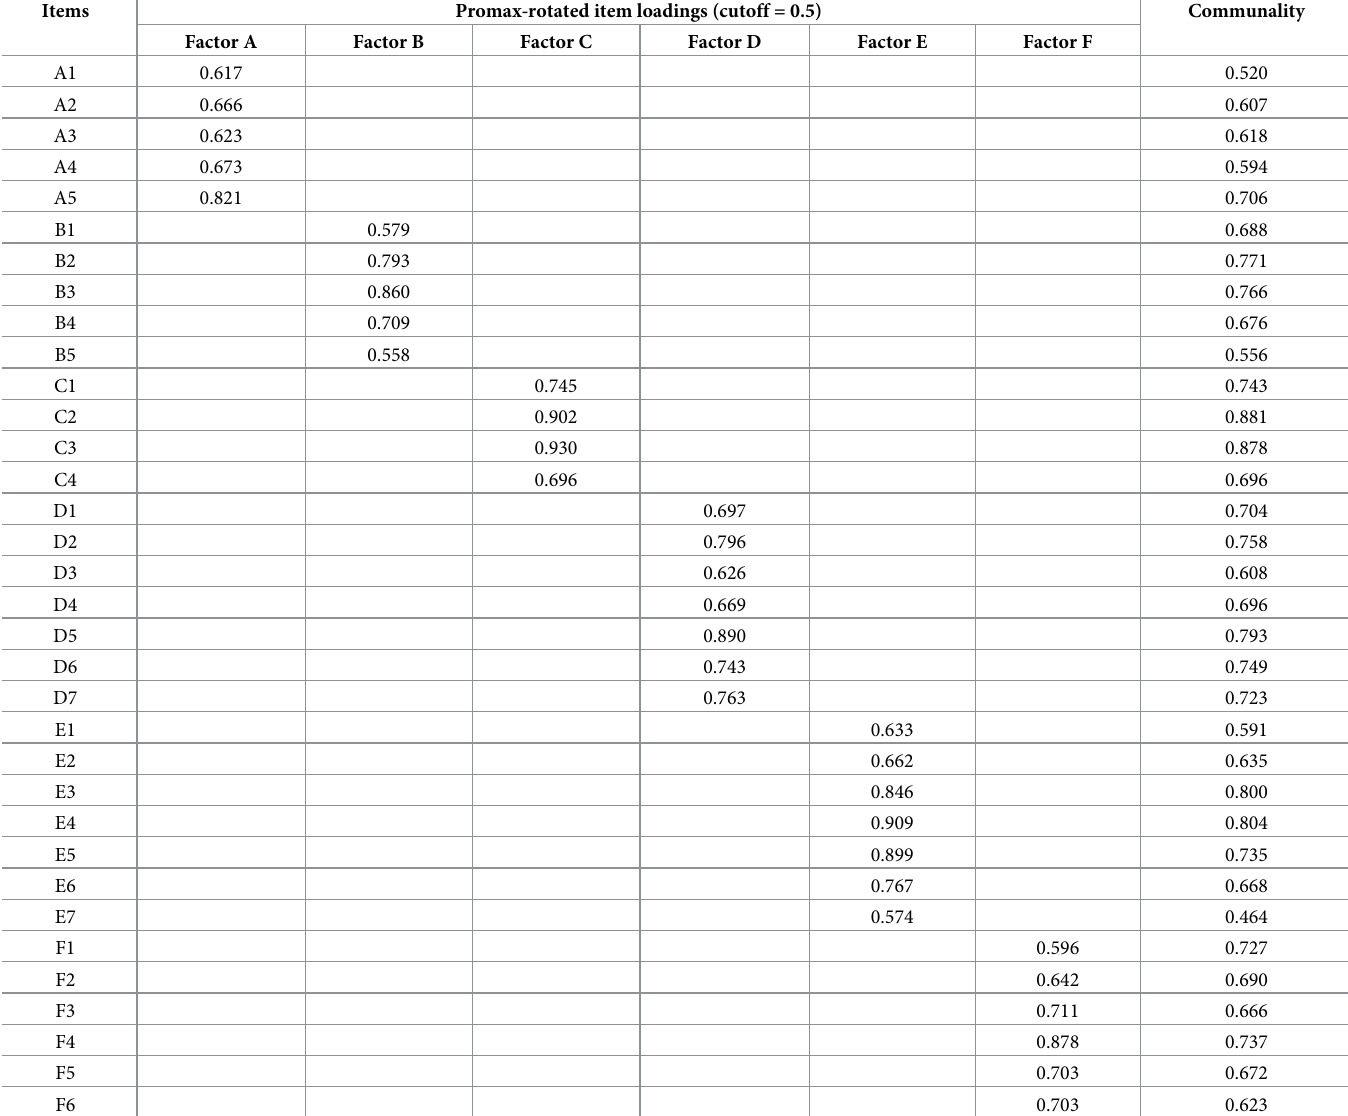
Table 3. Promax-rotated item loadings of 34 items in the final six-factor model. Items Promax-rotated item loadings (cutoff = 0.5)